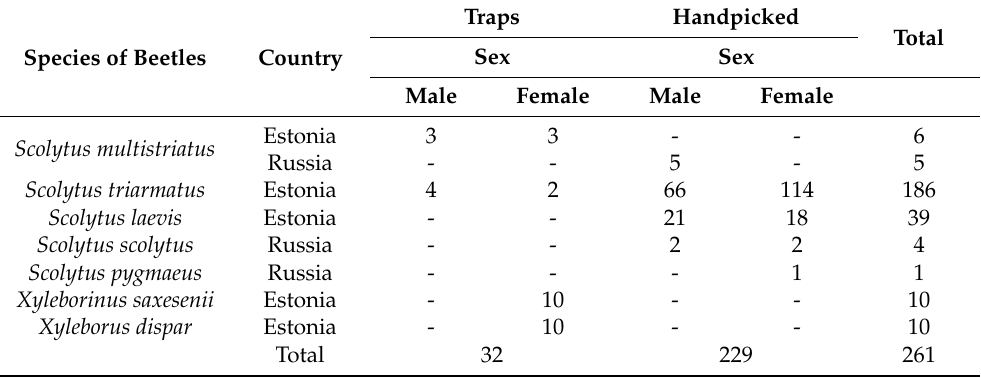
Table 1. Potential vector beetle species of DED caught with traps and handpicked from symptomatic